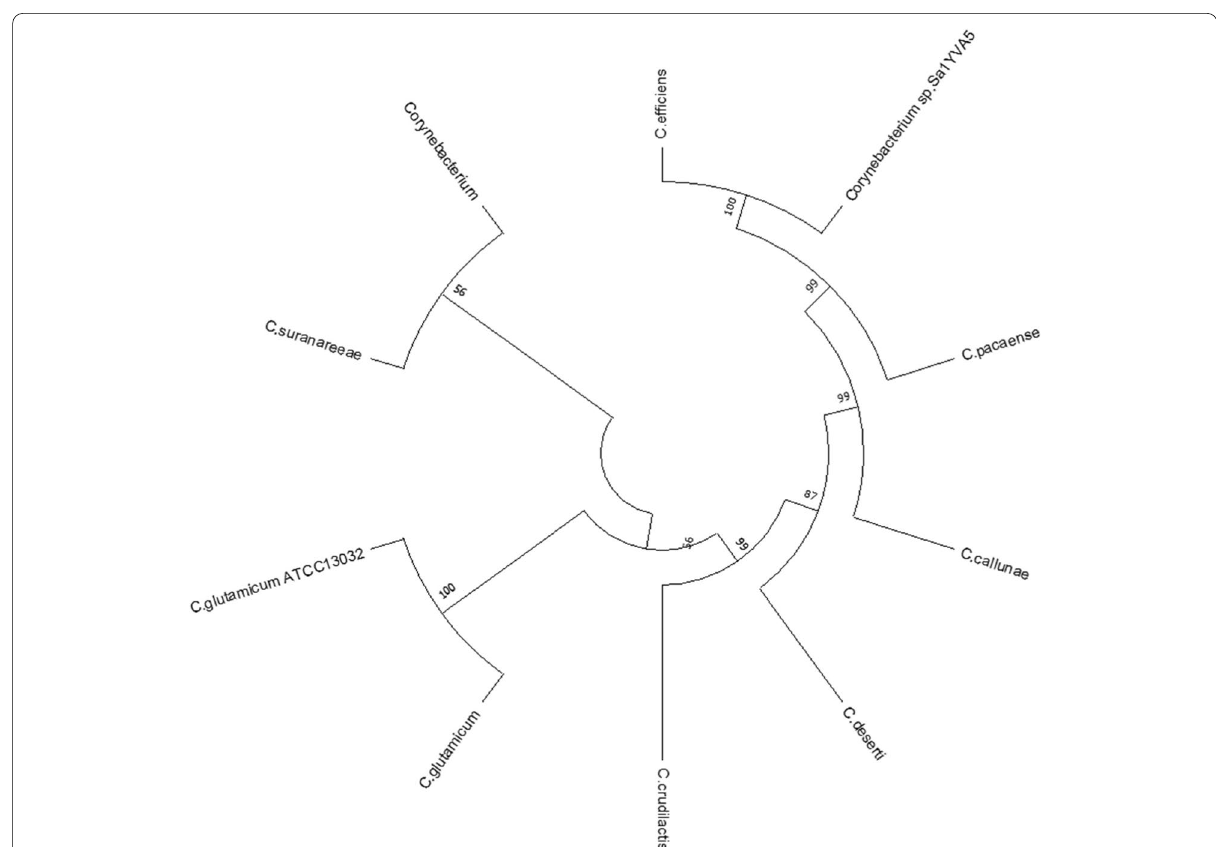
Fig. 2 Phylogenetic tree of nitrilase protein sequences from Corynebacterium sp. Constructed by NJ method